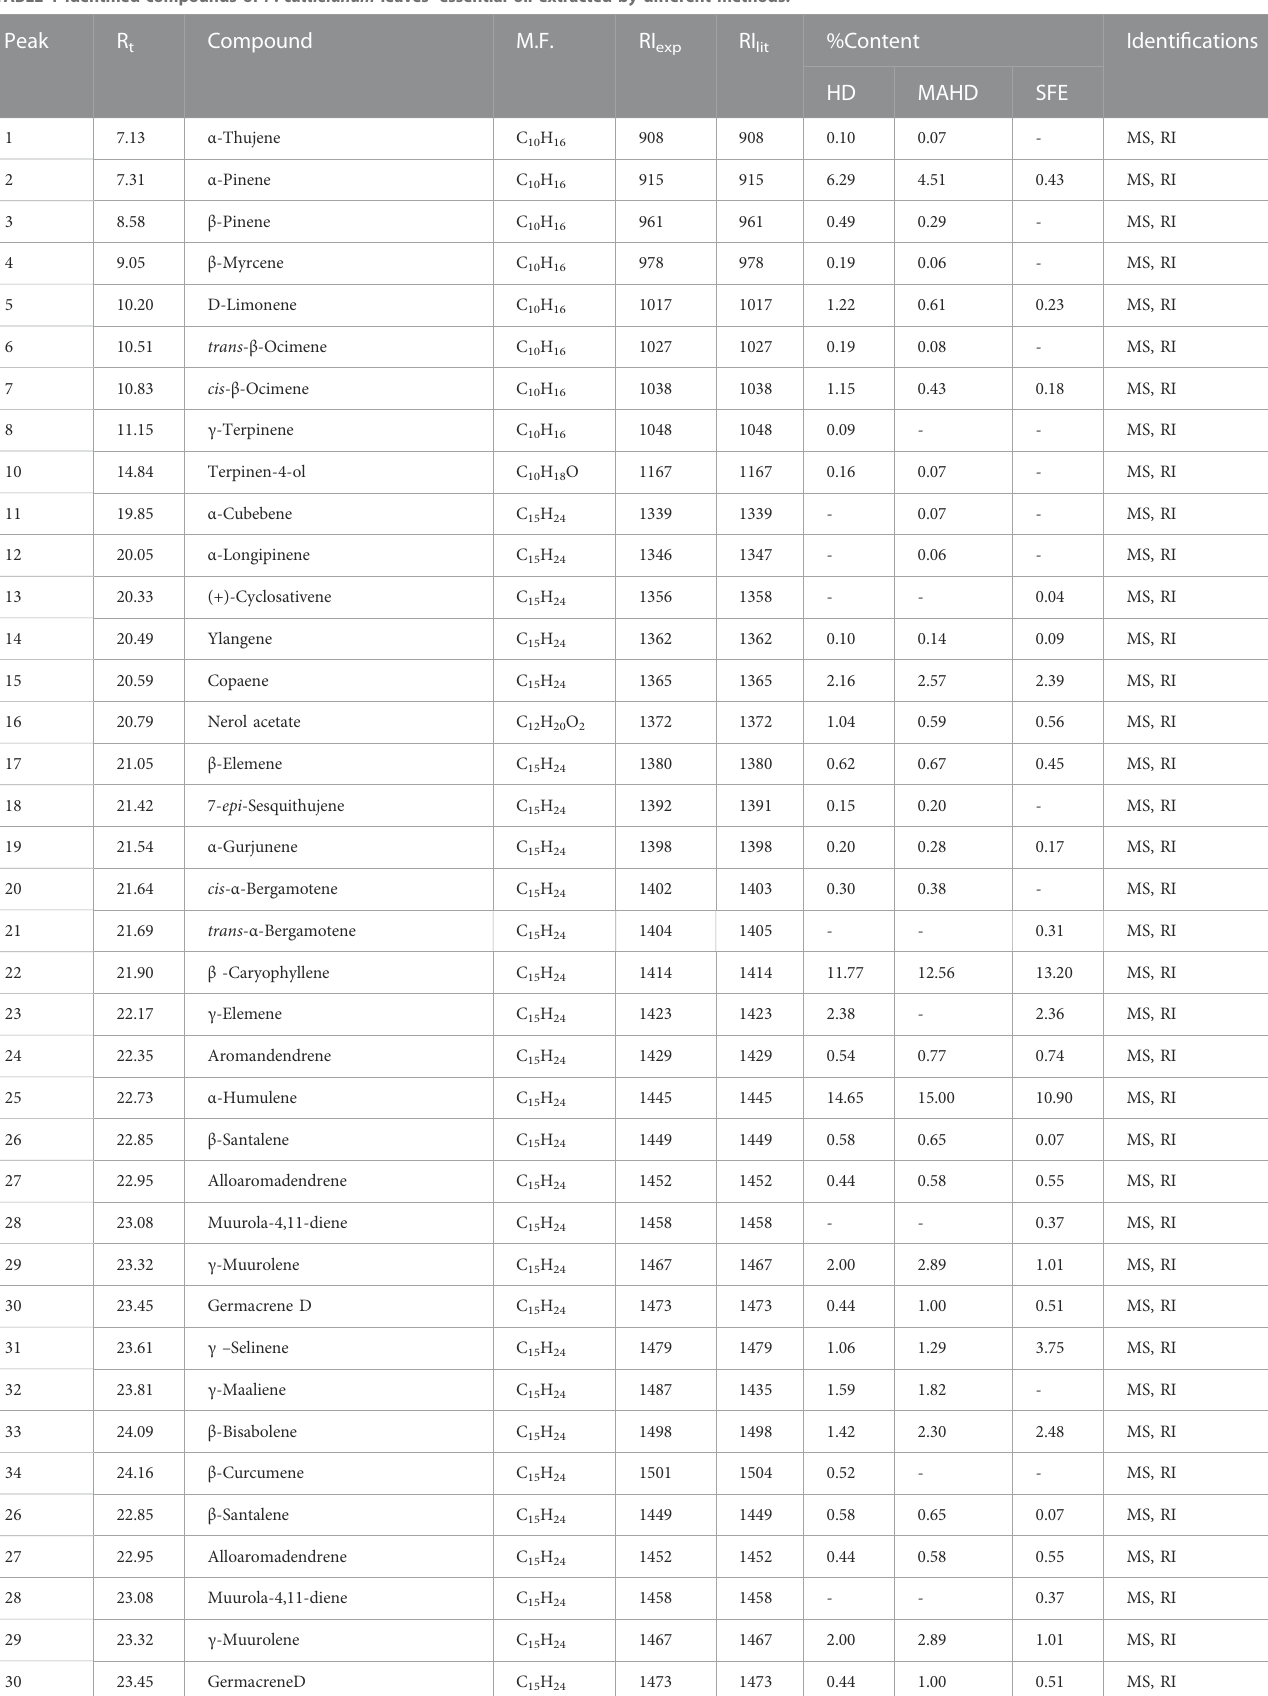
TABLE 1 Identi fi ed compounds of P . cattleianum leaves ’ essential oil extracted by different methods.